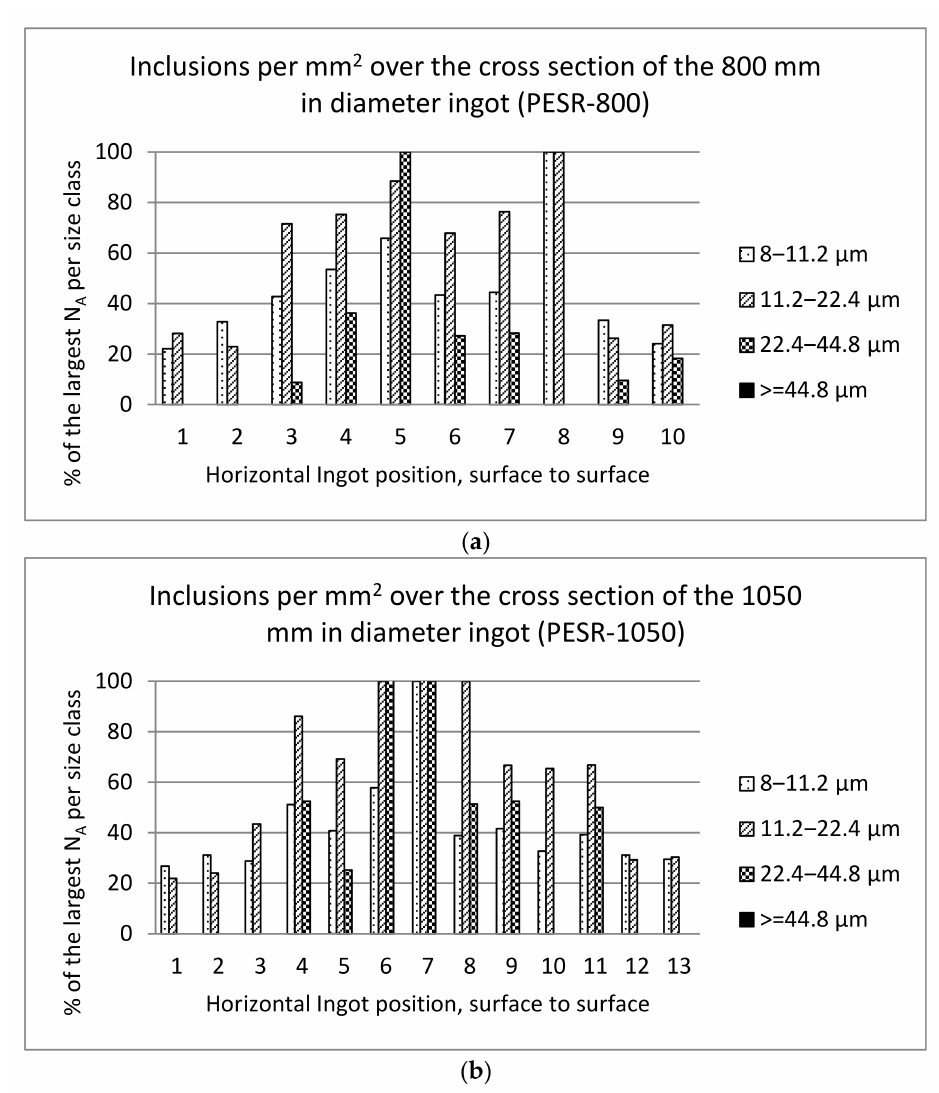
Figure 11. Inclusion measurement over the cross-sections for the pressure electro-slag remelted ( a ) 800 mm diameter (PESR-800) and ( b ) 1050 mm diameter (PESR-1050) unprocessed ingots. No inclusions > 44.8 µ m were